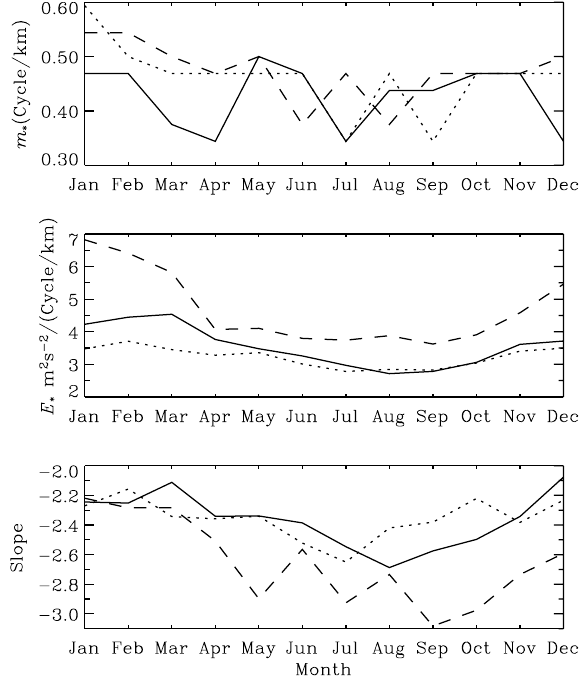
Fig. 5. Monthly variations of the characteristic wave numbers (up- per panel), spectral amplitudes (middle panel) and slopes (bottom panel) of the mean vertical wave number spectra for GWs in the tro- posphere over Wuhan station. The solid, dotted and dashed curves denote the spectral parameters for the zonal kinetic energy, merid- ional kinetic energy and potential energy densities,